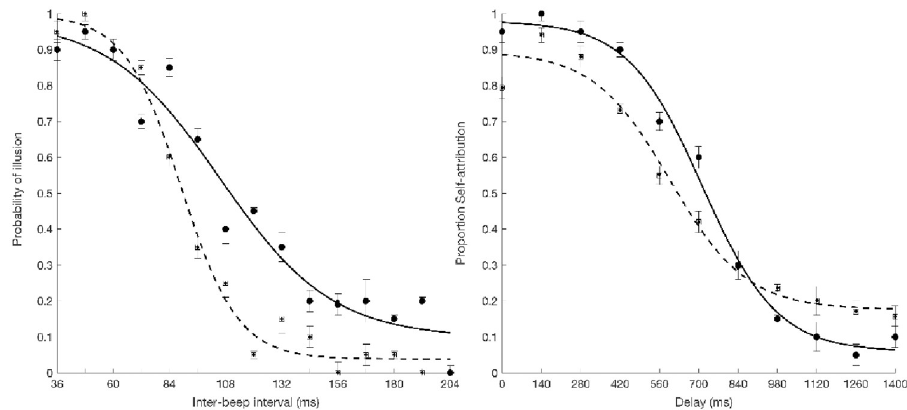
Fig 7. Effect of occipital tACS stimulation on TBW and SoA window. (A) Average percentage of probability of perceiving the illusion plotted as a function of inter-beep delay. A sigmoid function was then fitted to the averaged data points. The black solid curve represents the sigmoid fit determining the point of decay of the illusion, corresponding to the width of the TBW, in 8Hz condition. The black dotted curve represents the sigmoid fit determining the point of decay of the illusion, corresponding to the width of the TBW, in 14Hz condition. The points represent across- participants average raw data with error bars showing standard error of the mean. (B) Average percentage of probability of self-attribution plotted as a function of delay. Data of each participant was first averaged for each delay and hereafter across all participants according to the delays. A sigmoid function was then fitted to the averaged data points. The black solid curve represents the sigmoid fit determining the point when the SoA judgement changes, corresponding to the width of the SoA window, in 8Hz condition. The black dotted curve represents the sigmoid fit determining the point when the SoA judgement changes, corresponding to the width of the SoA window, in 14Hz condition. The points represent across-participants average raw data with error bars showing standard error of the